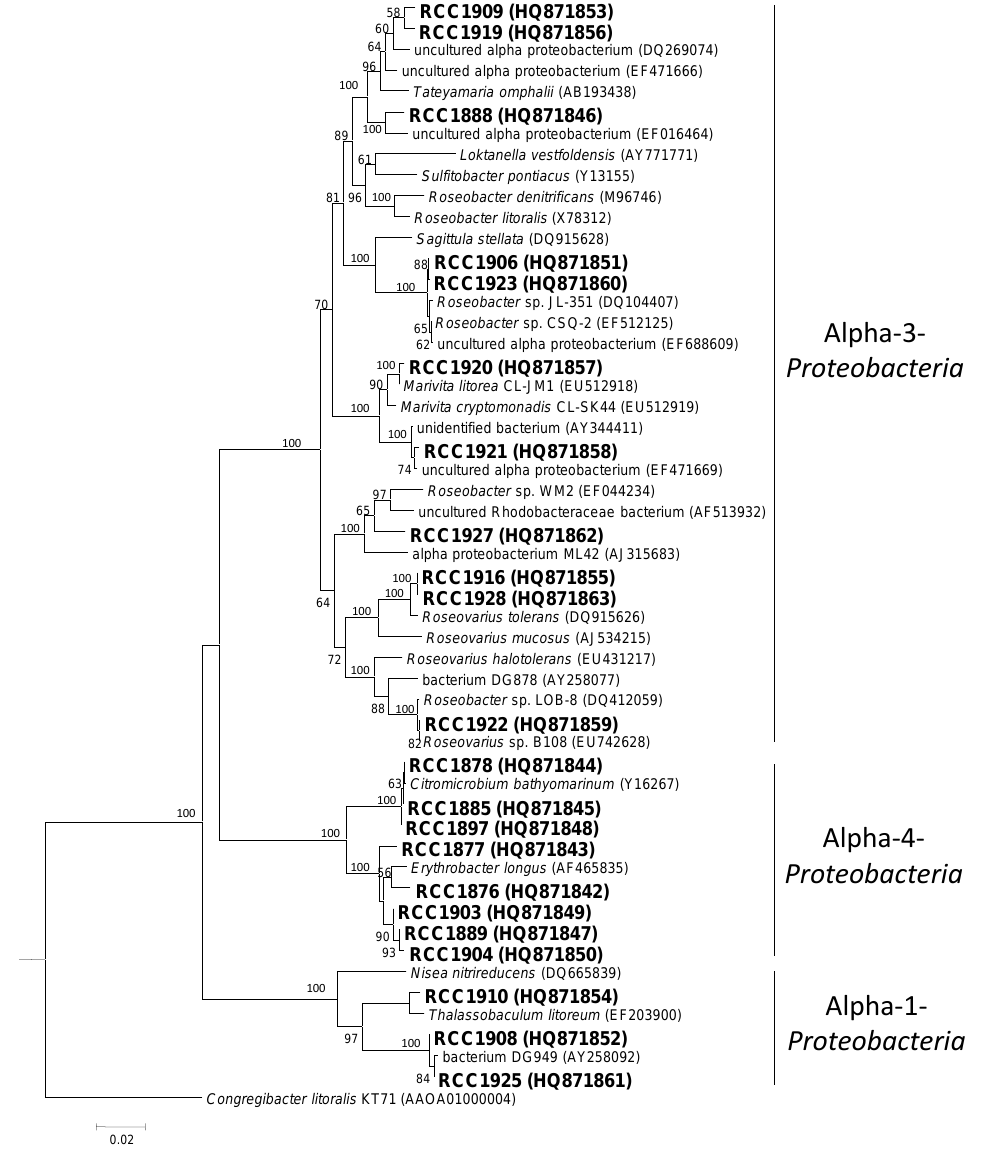
Fig. 2. Phylogenetic analysis based on the 16S rRNA sequences indicating the position of selected AAP strains isolated during the BOUM cruise. The tree was calculated by the neighbor-joining method. Percentages of 1000 bootstrap resamplings that support branching points above 50% are indicated. Bar represents the number of substitutions per 100 sequence